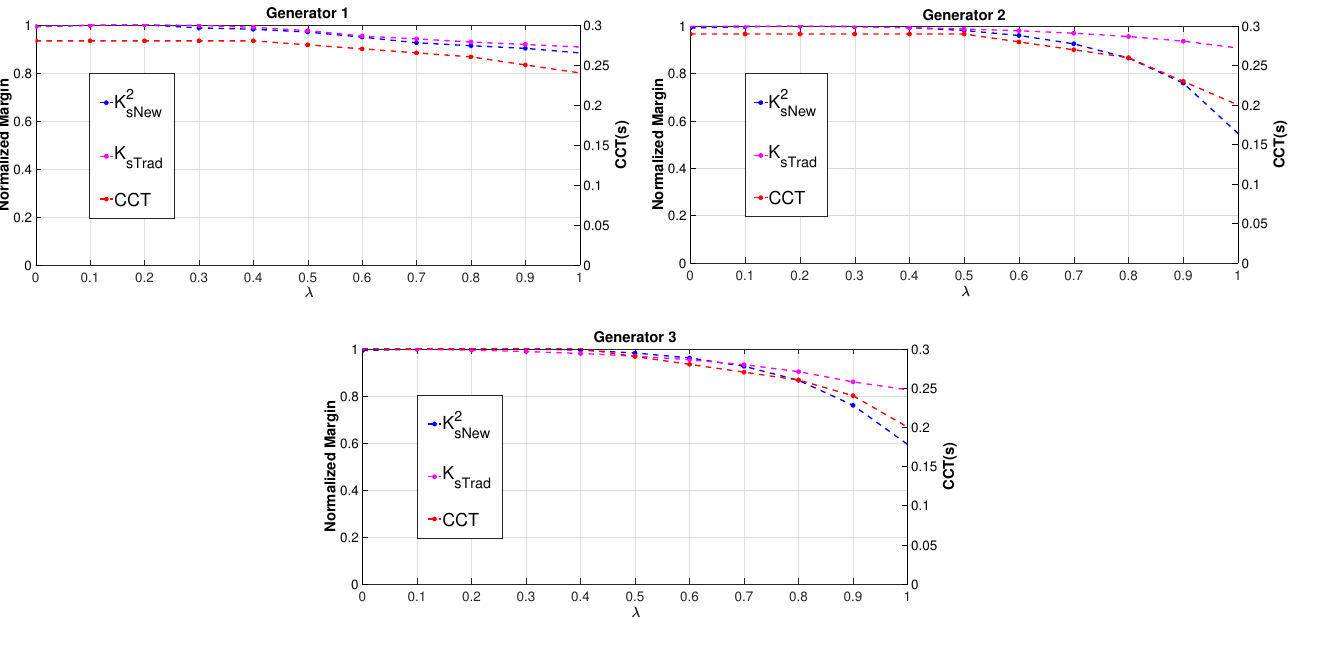
Figure 2. Transient stability margin of generators in WSCC 9-bus test system for mode